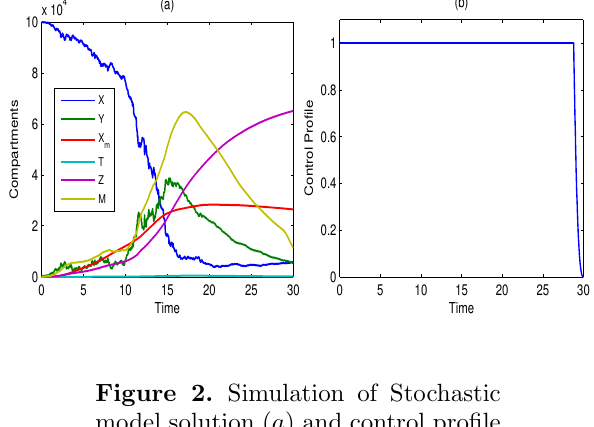
Figure 2. Simulation of Stochastic model solution ( a ) and control profile u ( t )( b )